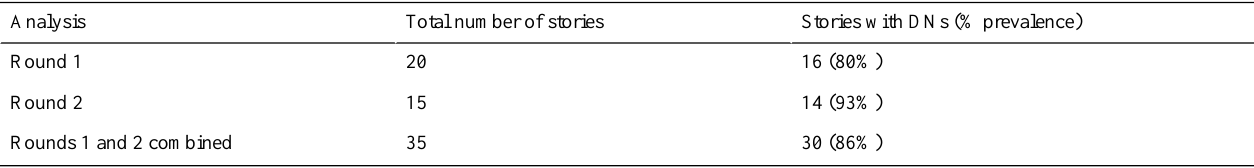
Table 1. Prevalence of diagnostic narratives (DNs) in YouTube survivorship